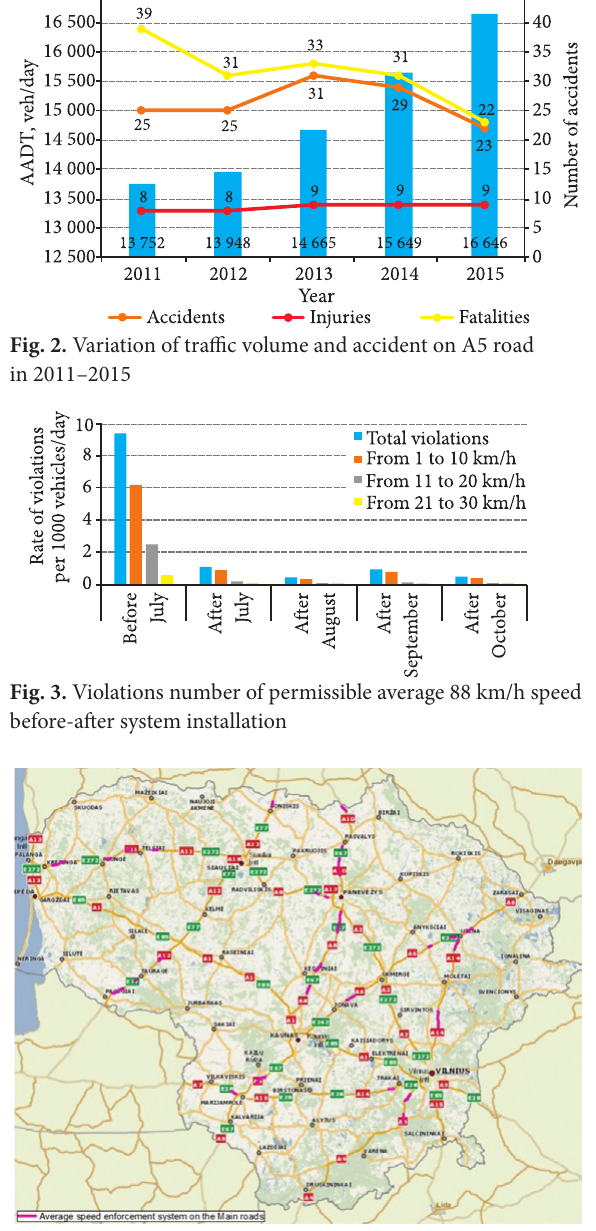
Fig. 4. Selected Lithuanian main road sections for the installation of